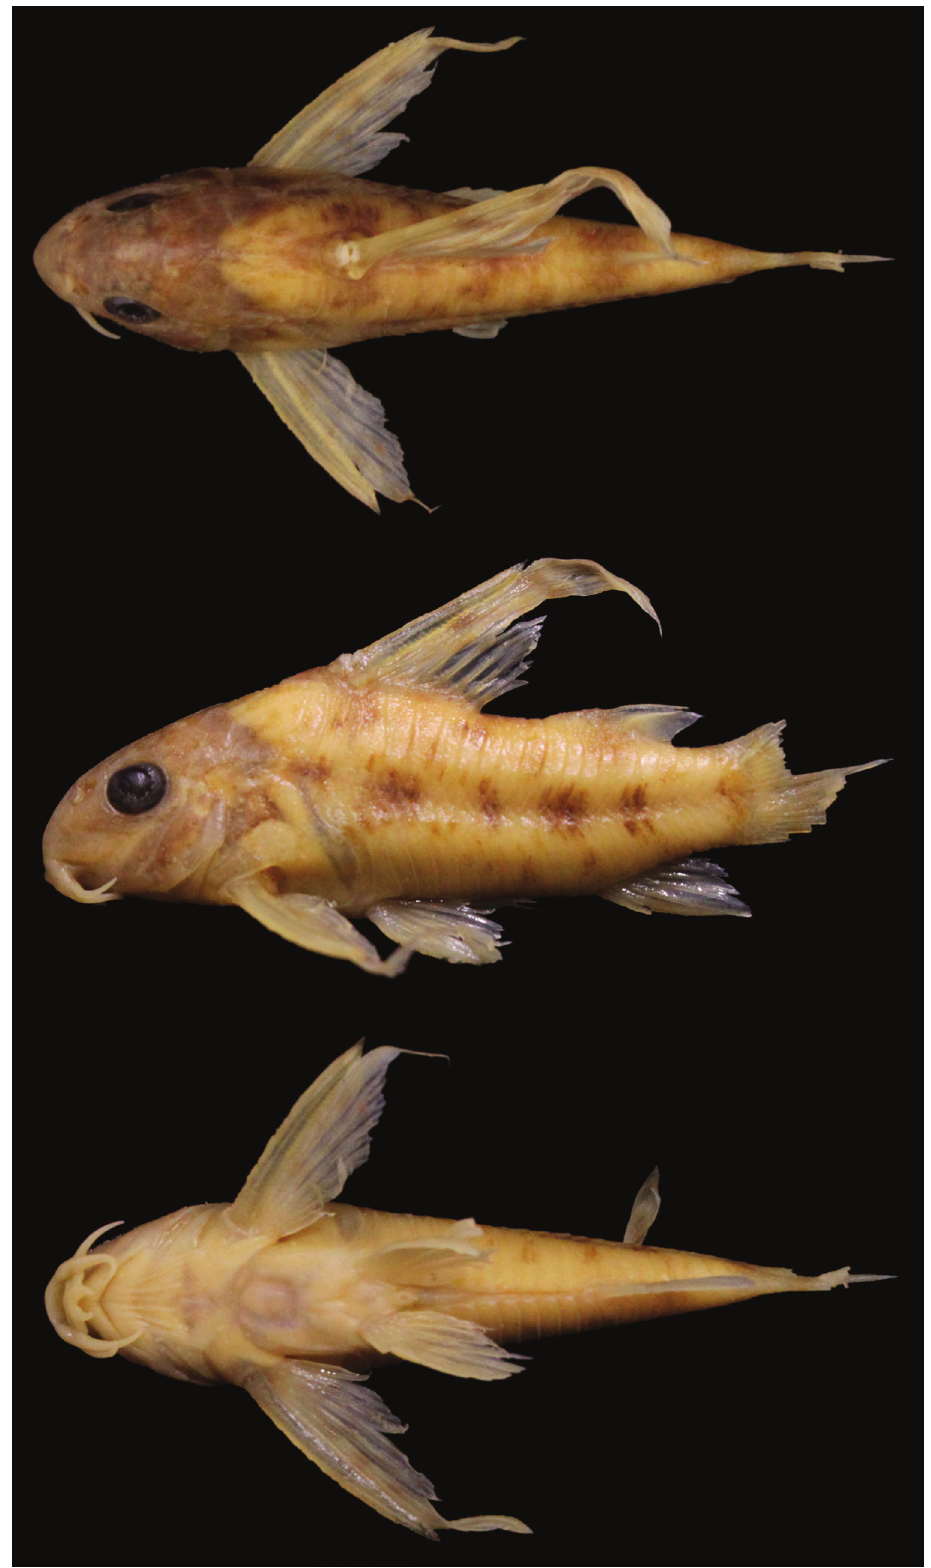
Fig. 1. Corydoras gryphus , holotype, MNRJ 40770, 32.3 mm SL, Brazil, Paraná, Foz do Iguaçu, rio Paraná (near to Ponte da Amizade), rio Paraná basin, approximately 25º31’S 54º38’W. Dorsal (top), lateral (middle) and ventral (bottom)